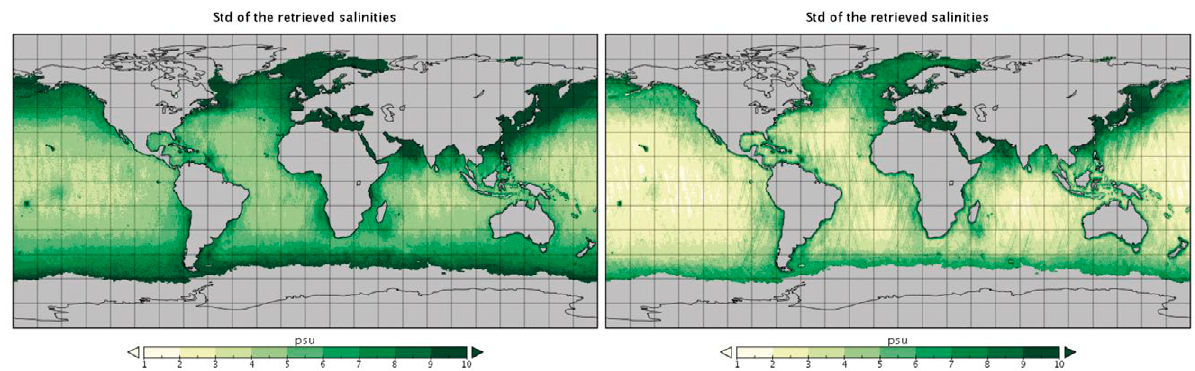
Fig. 2. – Maps of the standard deviation of single-angle SSS (Sea Surface Salinity) distributions. Left, SSS from nominal TB; right, SSS from nodal sampling TB. A reduction of 1.7 psu (practical salinity units) in the standard deviation of SSS distributions is obtained at a global scale when using the nodal sampling